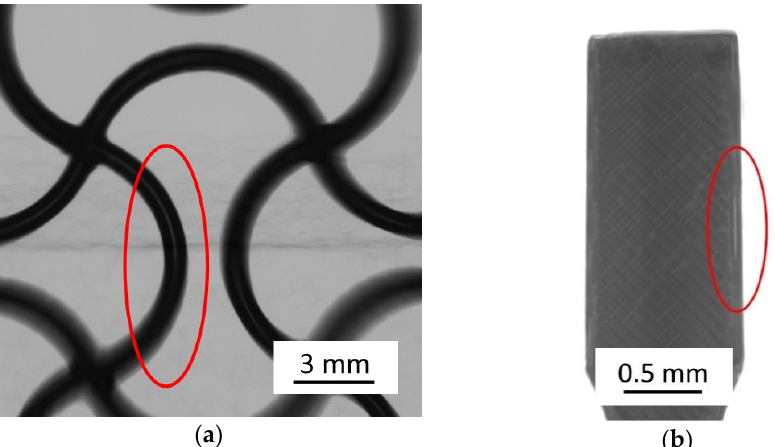
Figure 5. ( a ) Radiography of auxetic green body with adhesion defects between two outlines, ( b ) Radiography of tension rod with adhesion defects in infill +45°/ − 45°and between infill and outline. The solvent debinding and heat treatment were performed according to Sections 2.4